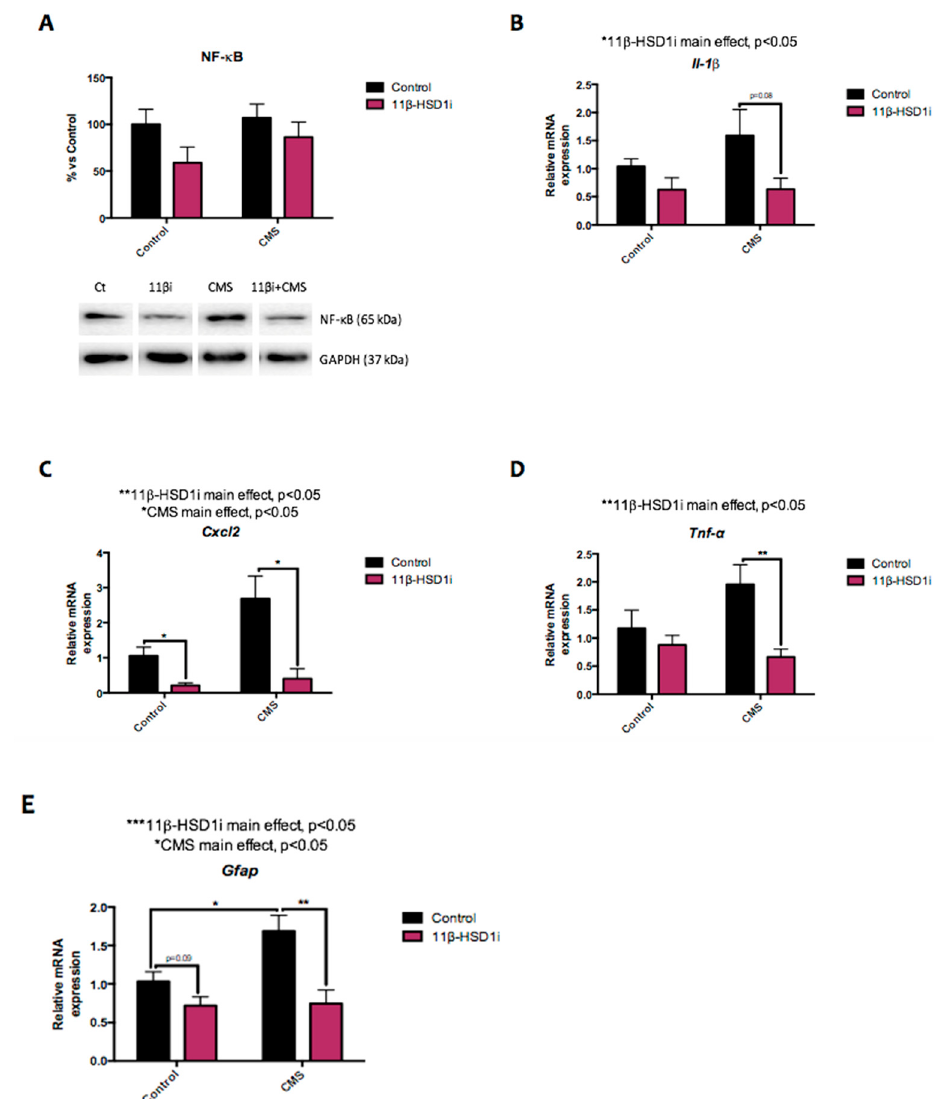
Figure 4. Representative results from inflammatory pathways. Representative Western blot for NF- κ B protein levels and quantification ( A ). Relative gene expression of Il-1 β ( B ), Cxcl2 ( C ), Tnf- α ( D ), and Gfap ( E ). Western blot values in bar graphs are adjusted to 100% for protein levels of SAMP8 Control (Control). Gene expression levels were determined by real-time PCR. Values are mean ± standard error of the mean (SEM) ( n = 6 for each group). 11 β -HSD1 and CMS main effects as well as interactions were determined. * p < 0.05; ** p <